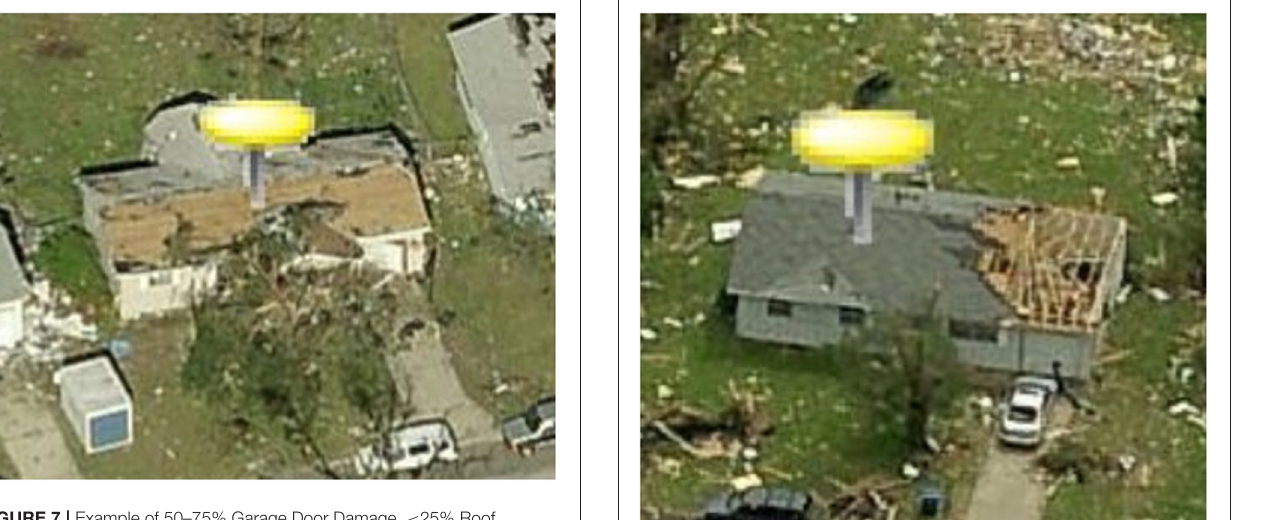
FIGURE 7 | Example of 50–75% Garage Door Damage, < 25% Roof Structural Damage. Image resolution and quality reduced for publication. Image courtesy of Eagleview Technologies, Inc. FIGURE 8 | Example of < 25% Garage Door Damage, 25–50% Roof